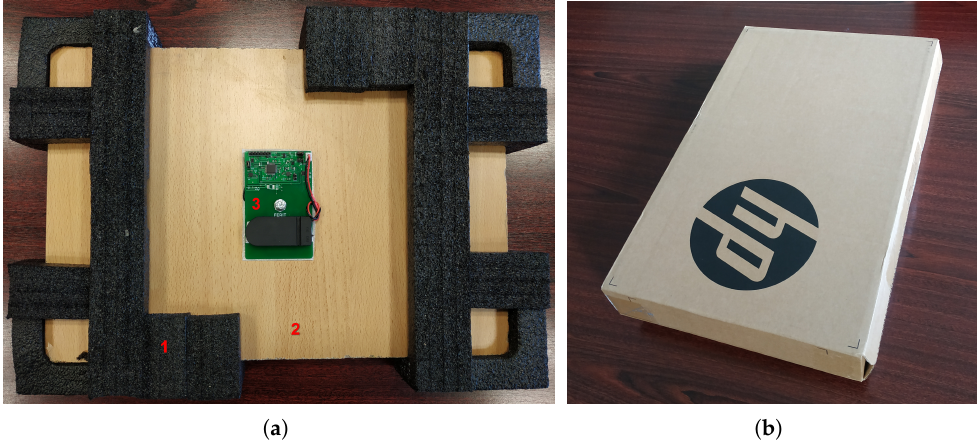
Figure 3. Smart Sticker prototype for shock detection on figure ( a ) (marked with 3) mounted on a testing package where 1 marks the cushioning material and 2 marks the ply board. Original cardboard box on figure ( b ).